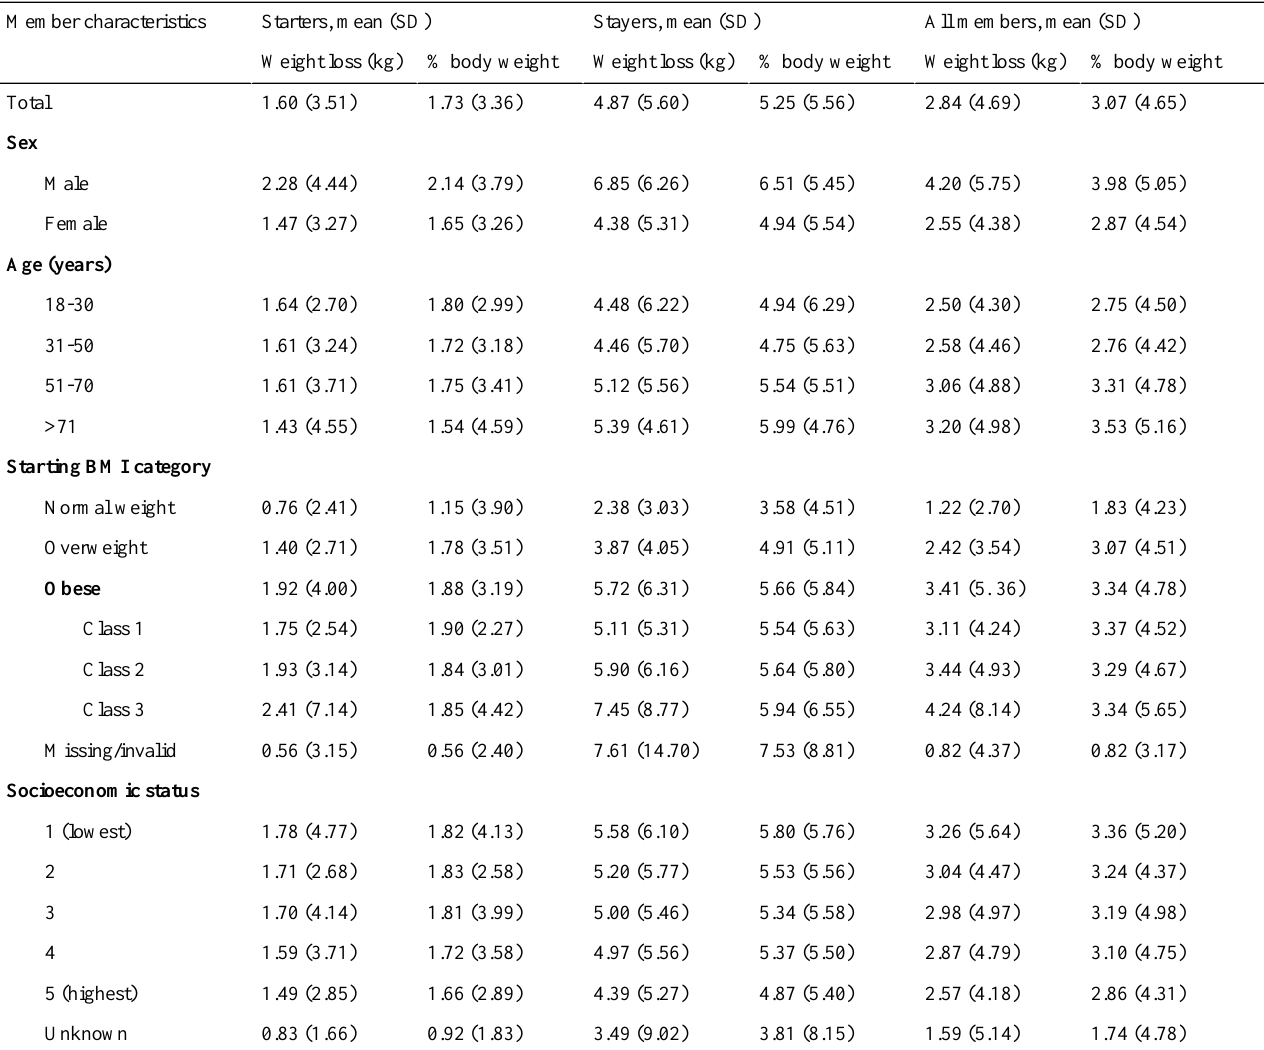
Table 2. Weight loss in kilograms and percentage of body weighta in starters (n=37,028), stayers (n=22,658), and all members (n=59,686) on the CSIRO Total Wellbeing Diet Online.